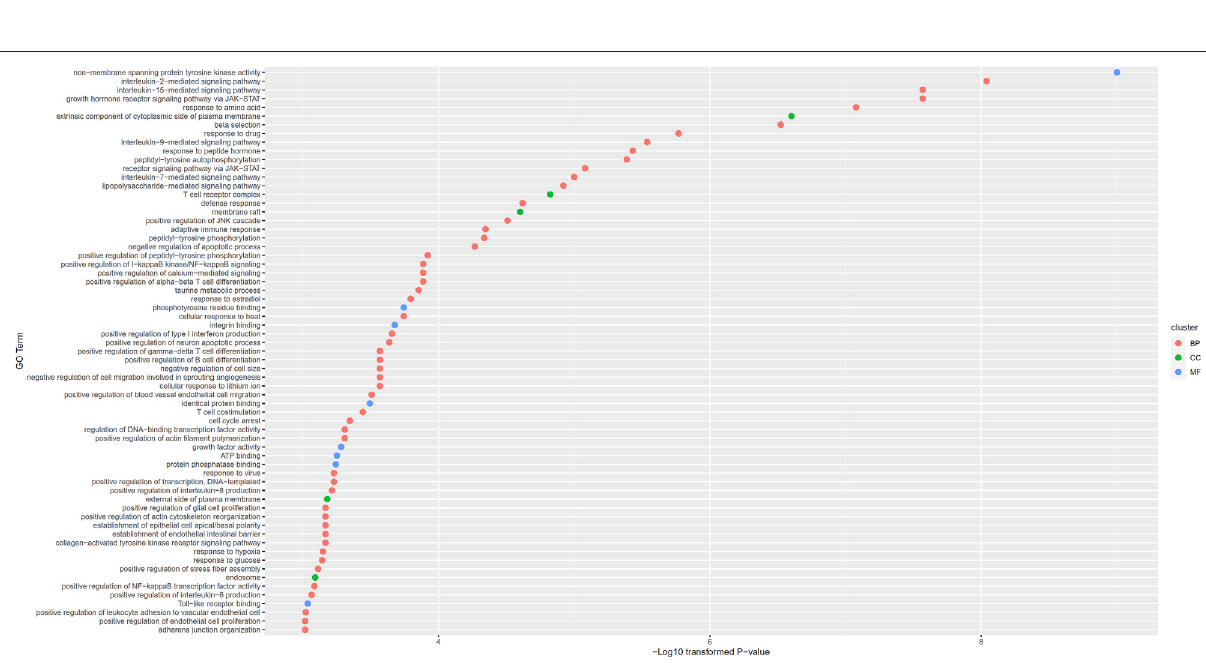
Frontiers in Cell and Developmental Biology |